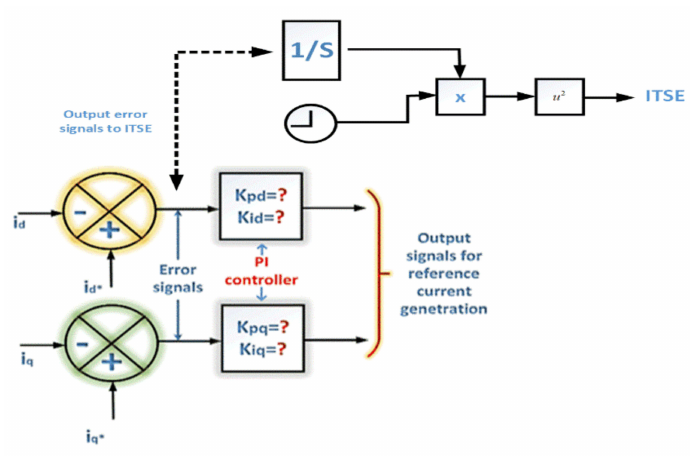
Figure 5. Proportional Integral (PI) controller loop with Integrated Time Square Error (ITSE) objective function block.